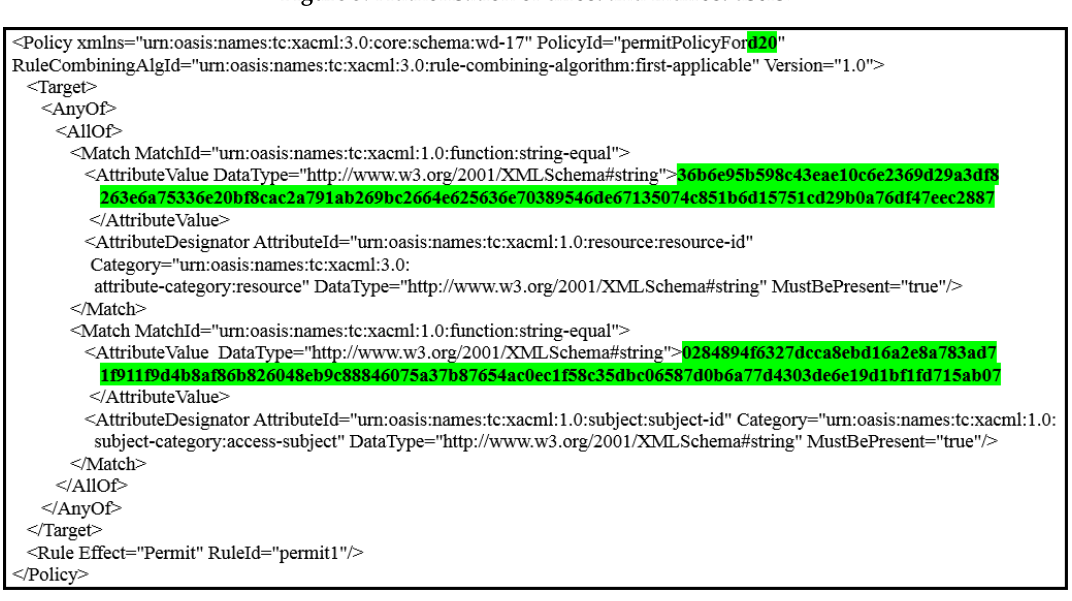
Figure 5. Authorisation of direct and indirect users.